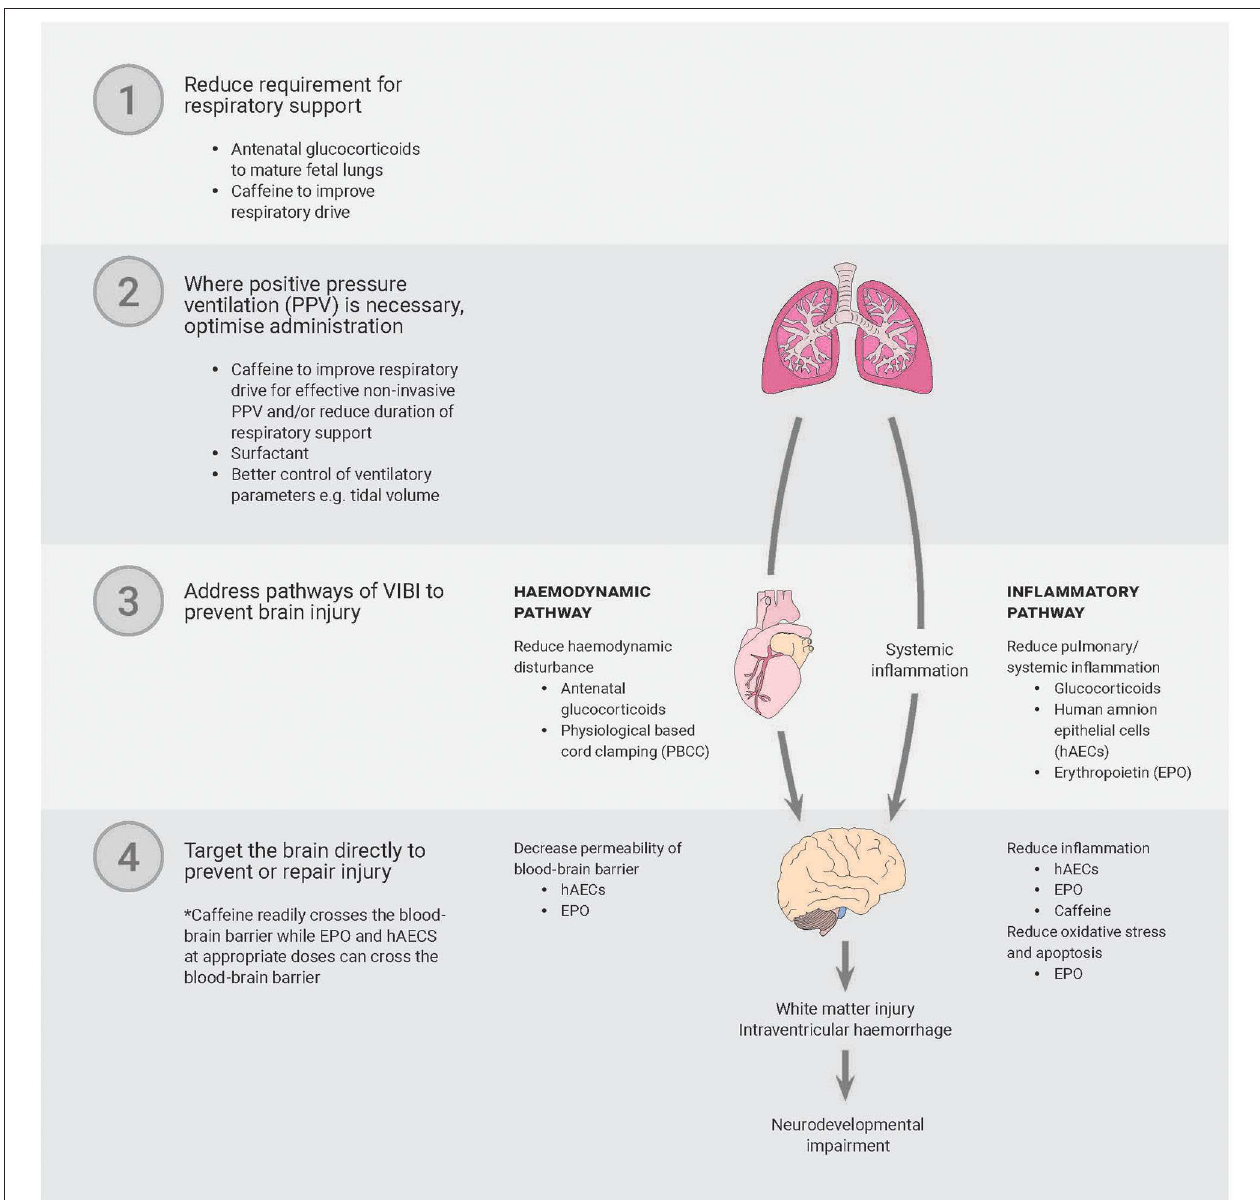
FIGURE 2 | A multipronged approach is likely necessary to prevent or reduce ventilation-induced brain injury. Only strategies discussed in-text have been included in the diagram. PPV, positive pressure ventilation; PBCC, physiological-based cord clamping; hAECs, human amnion epithelial cells; EPO,